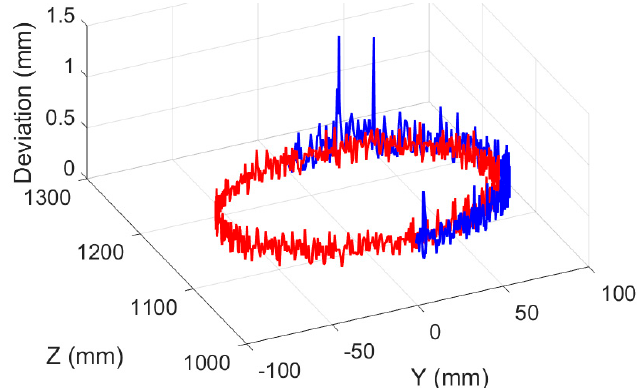
Figure 33. Deviation results of target planning path and actual tool path of experimental deburring for distal side facet.